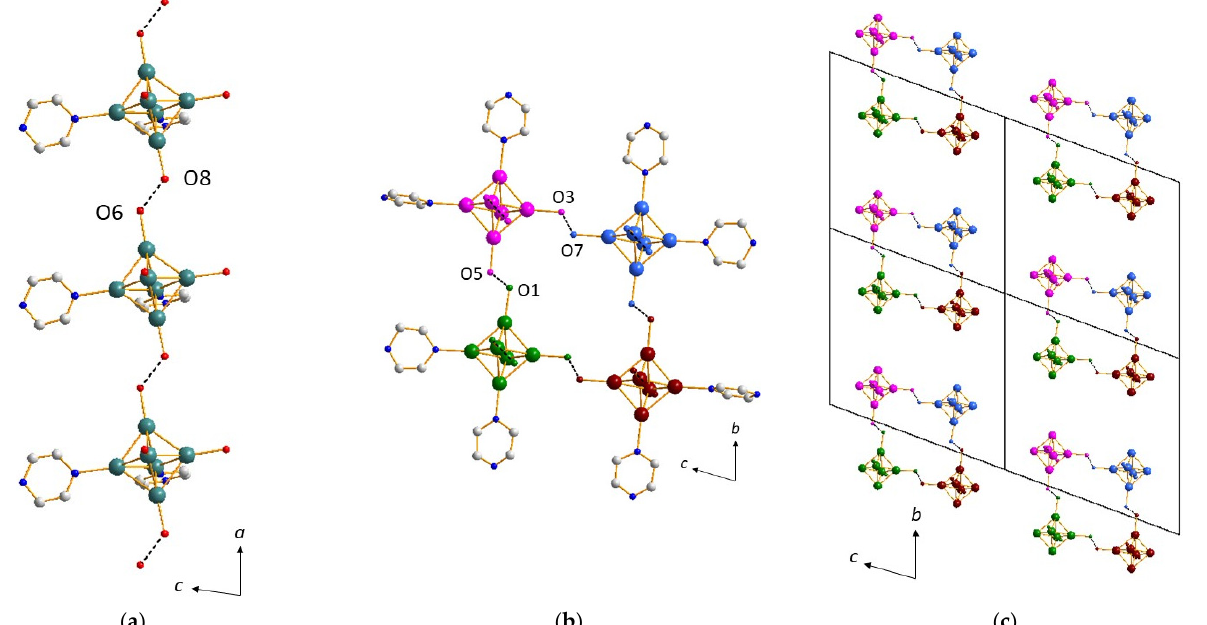
Figure 3. ( a ) Infinite chain through strong H-bonding along the a axis in the structure of ( 2 ). ( b ) Connection of adjacent chains through H 3 O 2 − bridges in the structure of ( 2 ) evidencing clusters tetramers. ( c ) Infinite tunnels running along the a axis in the structure of ( 2 ).